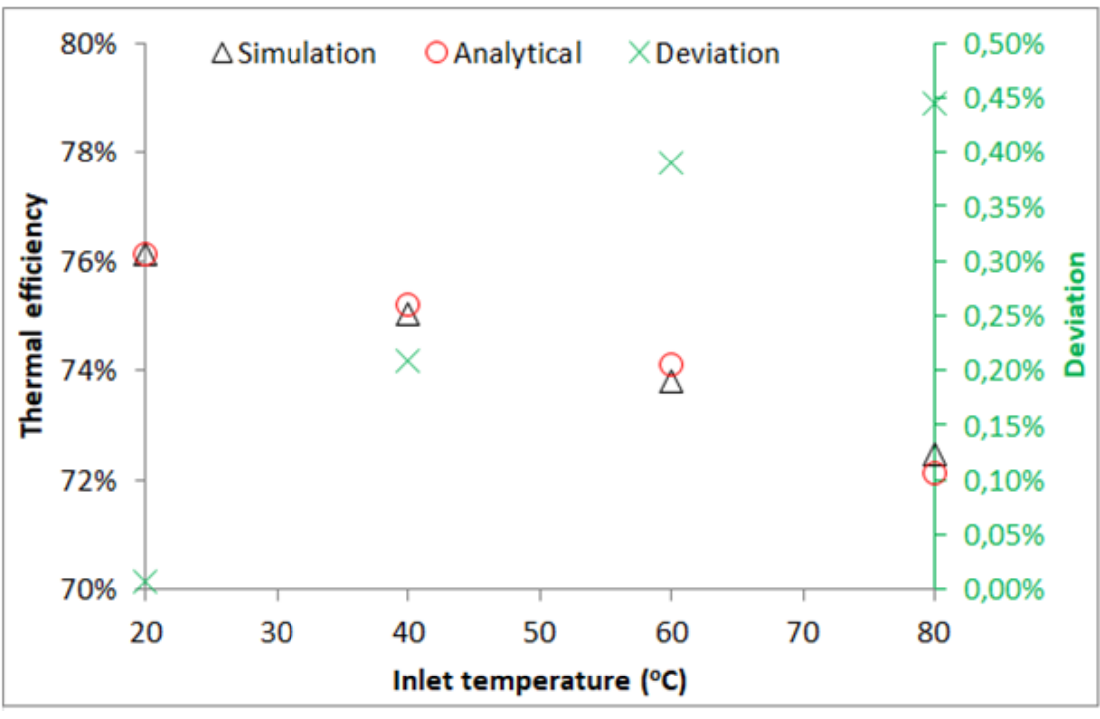
Figure 4. Verification regarding thermal efficiency.